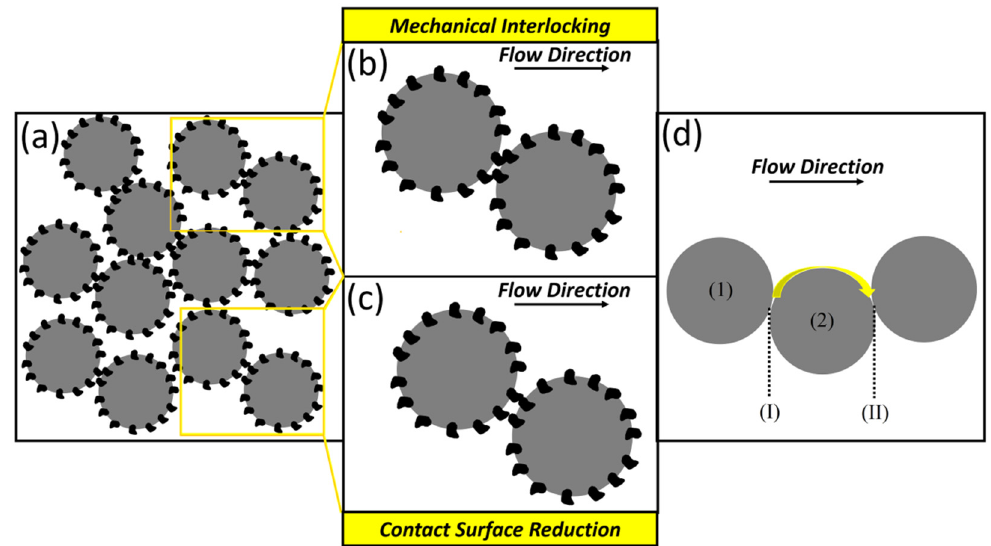
Figure 10. Schematic illustration presenting: ( a ) an overview of composite powder system with guest-decorated host particles; ( b , c ) close view of the selected regions showing “Mechanical Interlocking” and “Contact Surface Reduction” mechanisms, respectively; and ( d ) the contact area of two host powder particles when flowing relative to each other.